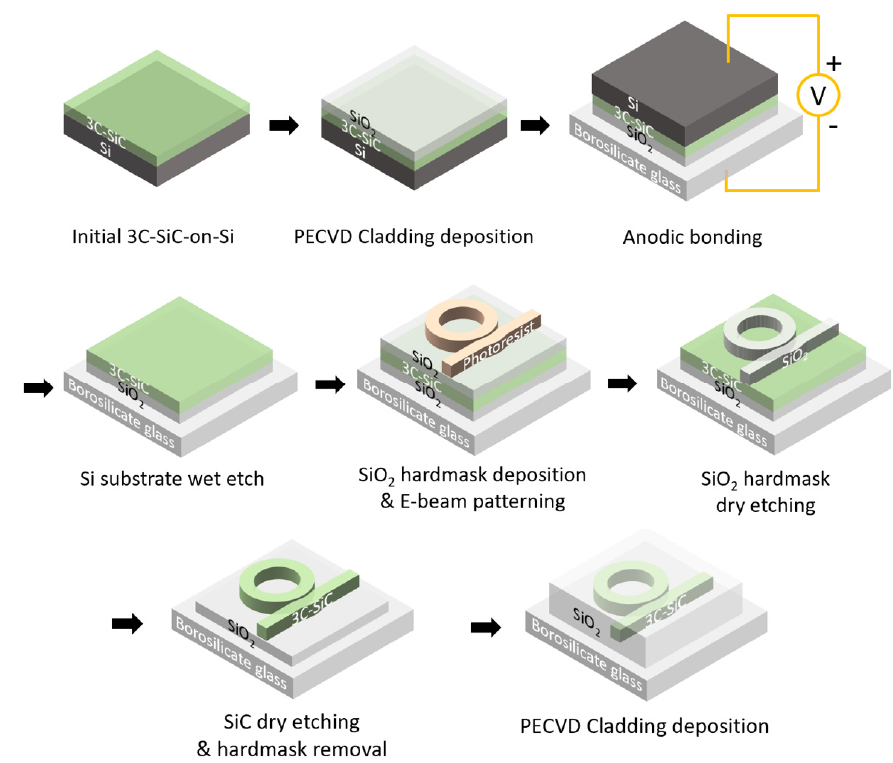
Figure 2. Schematics of the key steps of the fabrication process.